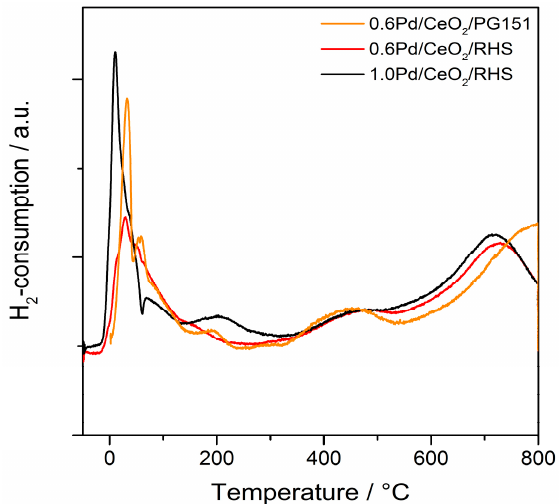
Figure 3. XRD (X-ray diffraction) patterns of CeO 2 , 0.6Pd/CeO 2 and x Pd/CeO 2 /RHS.